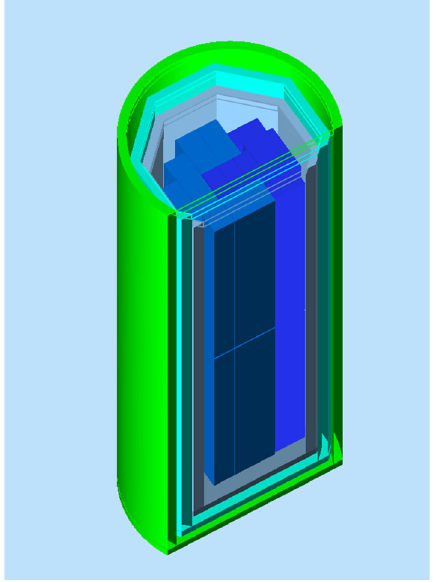
Fig. 6 Geant4 implementation of the BDX-MINI detector – for better visibility, the inner/outer veto top caps and the tungsten top shielding are shown in wireframe style. See text for details